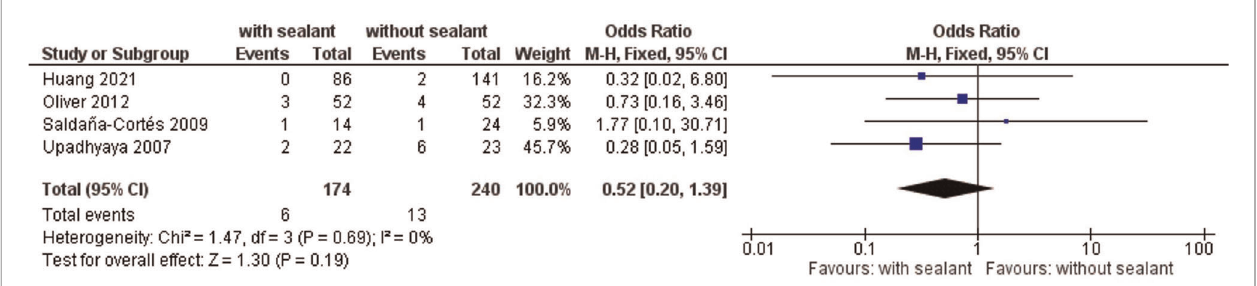
FIGURE 6 | Fixed-effects meta-analysis for the postoperative mortality rate in the intervention (coated or reinforced anastomoses) and control group. The forest plot of all studies is included.